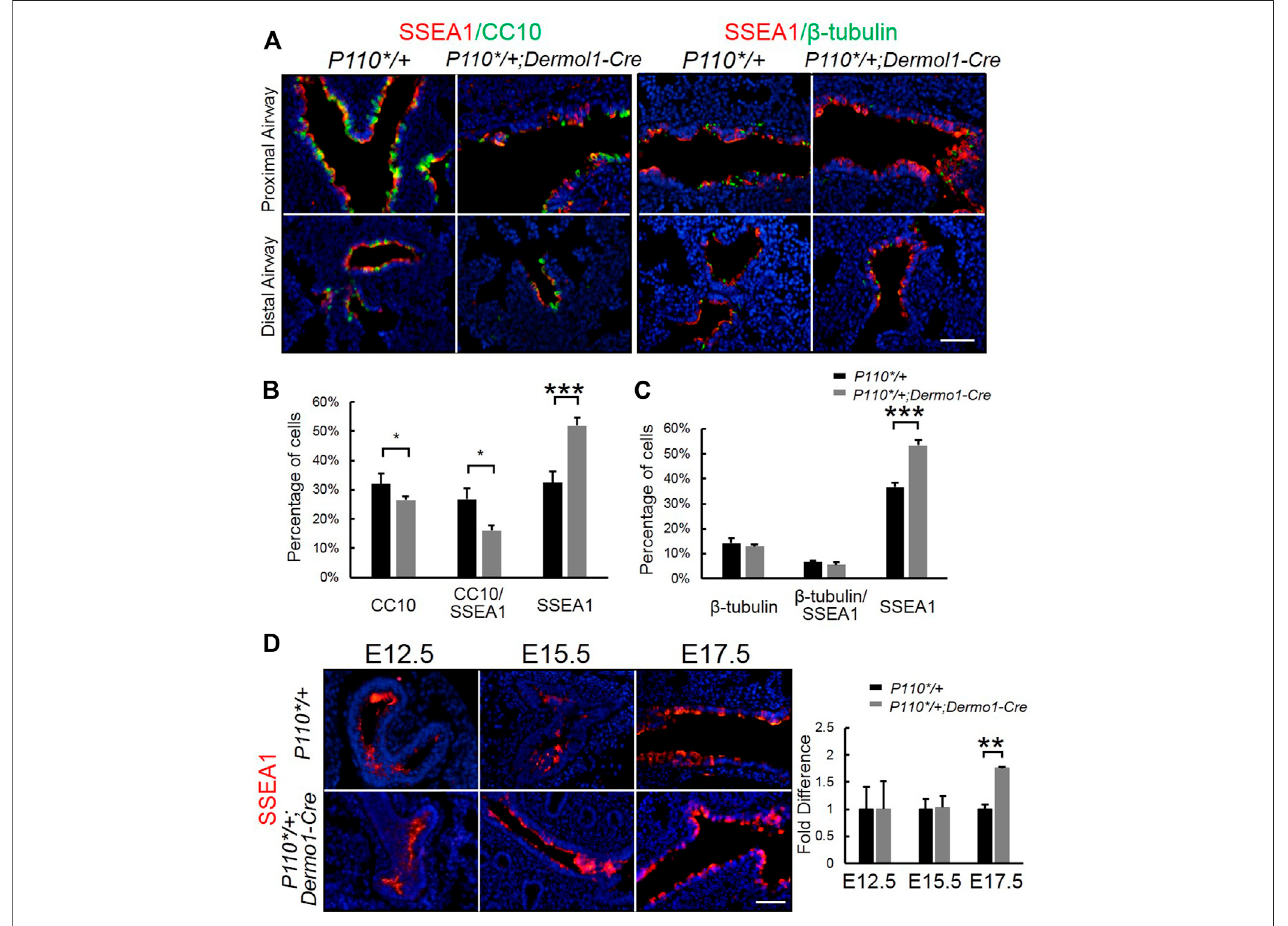
FIGURE 5 | Activation of p110 α inhibits the differentiation of epithelial progenitor cells. (A) . Double IF staining analysis of CC10, SSEA1, and ß -tubulin in E17.5 control and P110*/+ ; Dermo1-cre lungs. (B,C) . The percentages of CC10, CC10/SSEA1, ß -tubulin, ß -tubulin/SSEA1, and SSEA1 cells in total E17.5 airway cells were countedonmultiplerandom fi elds. (D) .IFstaininganalysisandreal-timePCRanalysisofSSEA1inE12.5,E15.5,andE17.5controland P110*/+ ; Dermo1-cre lungs.The bars represent the mean ± SD. N > 3. *p < 0.05, ** p < 0.01 ***p < 0.001 Scale bar: 50 μ m.